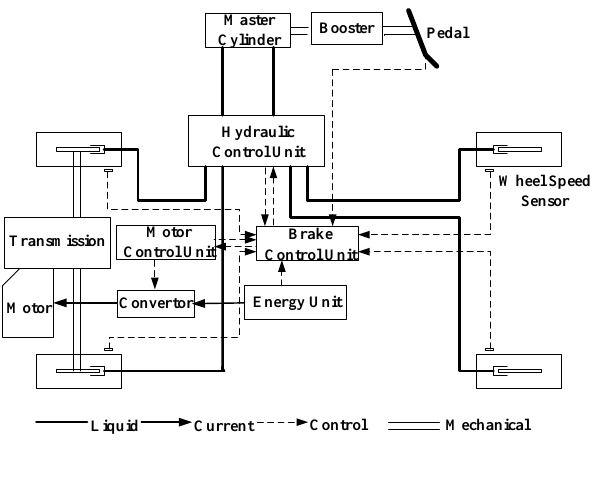
Figure 1. Configuration of the braking control